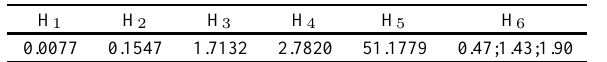
Table 2 Dimensionless parameters used in the numerical